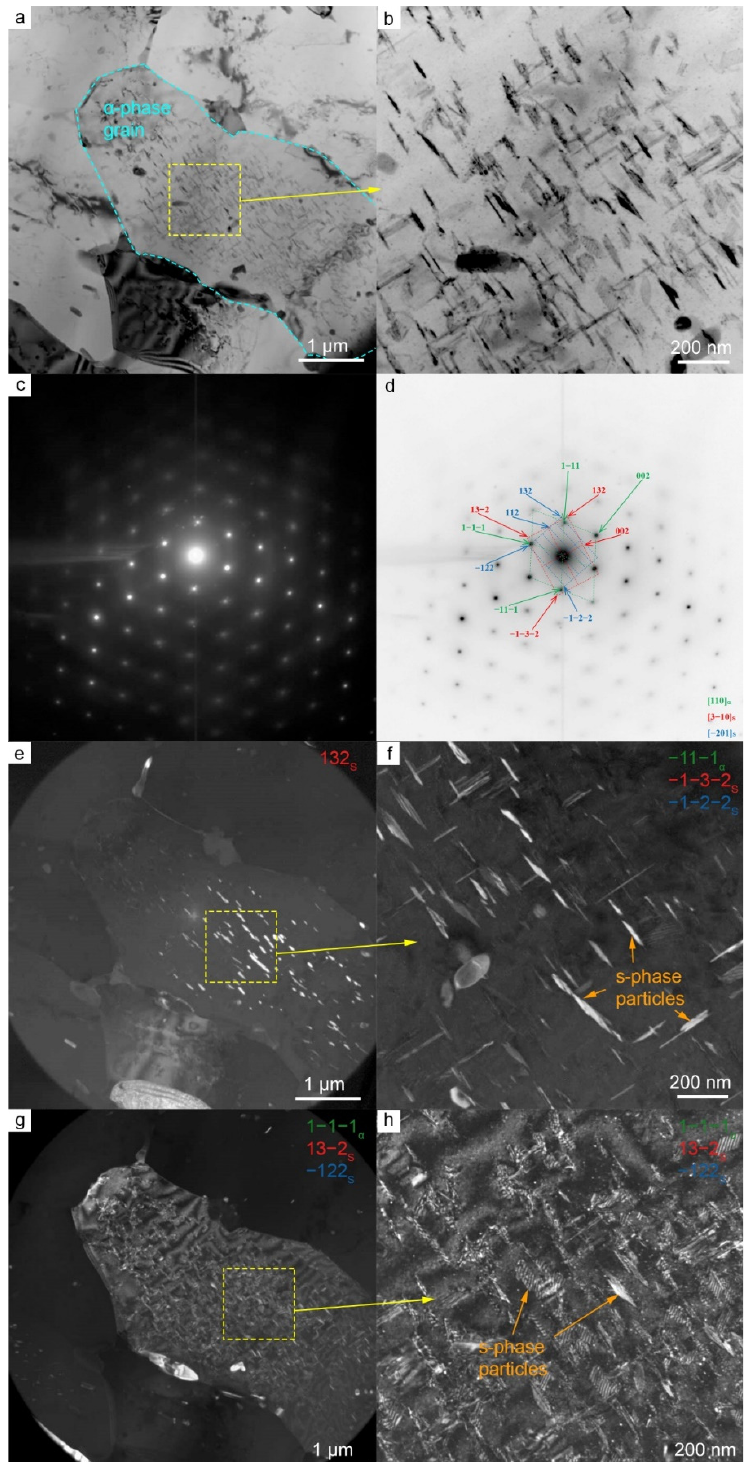
Figure 8. Microstructure of AA2024 in the SZ of FSW joint. Bright ‐ field ( a , b ) and dark ‐ field ( e – h ) TEM images, SAED ( c ) and SAED pattern indexing ( d ). Dark ‐ field images taken in the reflection 132 S ( e ), group of reflections − 11 − 1 α & − 1 − 3 − 2 S & − 1 − 2 − 2 S ( f ), and group of reflections 1 − 1 − 1 α & 13 − 2 S & − 122 S ( g , h